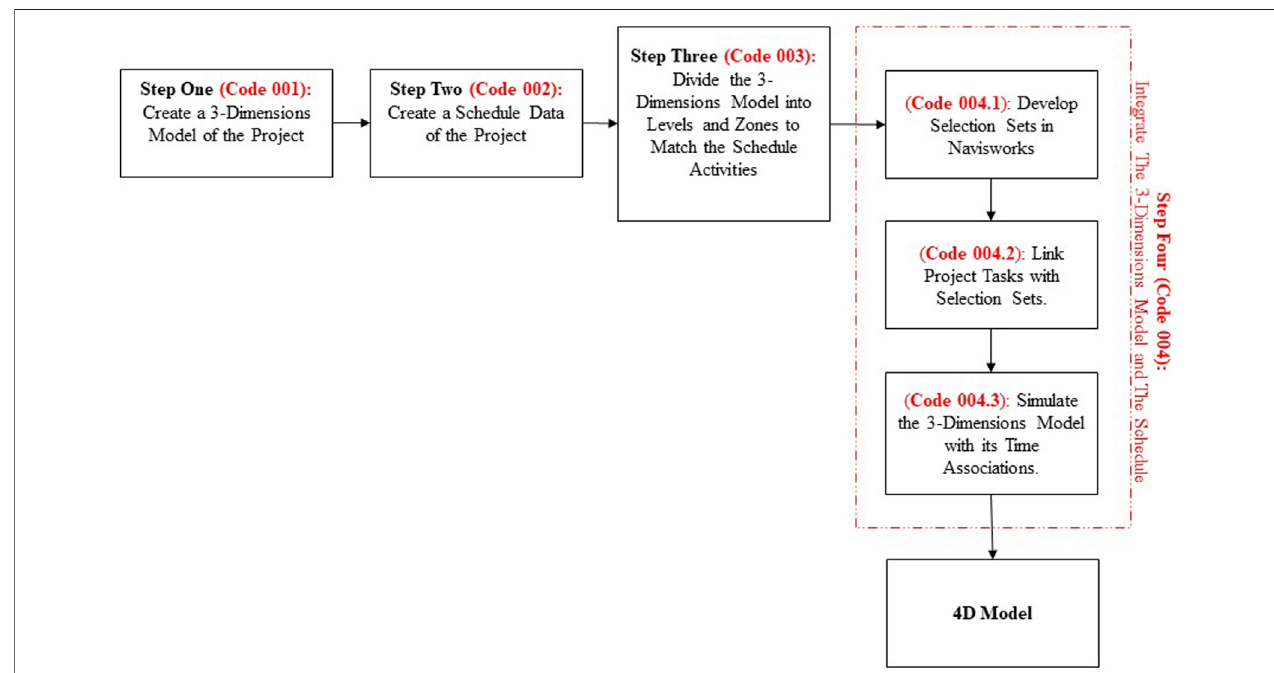
FIGURE 1 | The proposed guideline work fl ow.